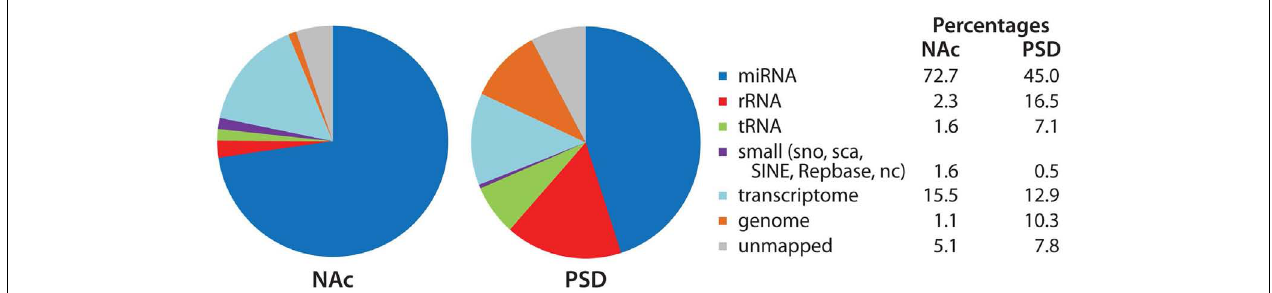
identify sequences that aligned with annotated non-coding and repetitive elements. Sequences were then aligned to the mouse transcriptome (exons, introns, exon–exon junctions) and mouse genome. For non-miRNA alignments, 1-mismatch was allowed. Data (% total reads mapped to each category) for the NAc and PSD libraries from saline-injected animals are